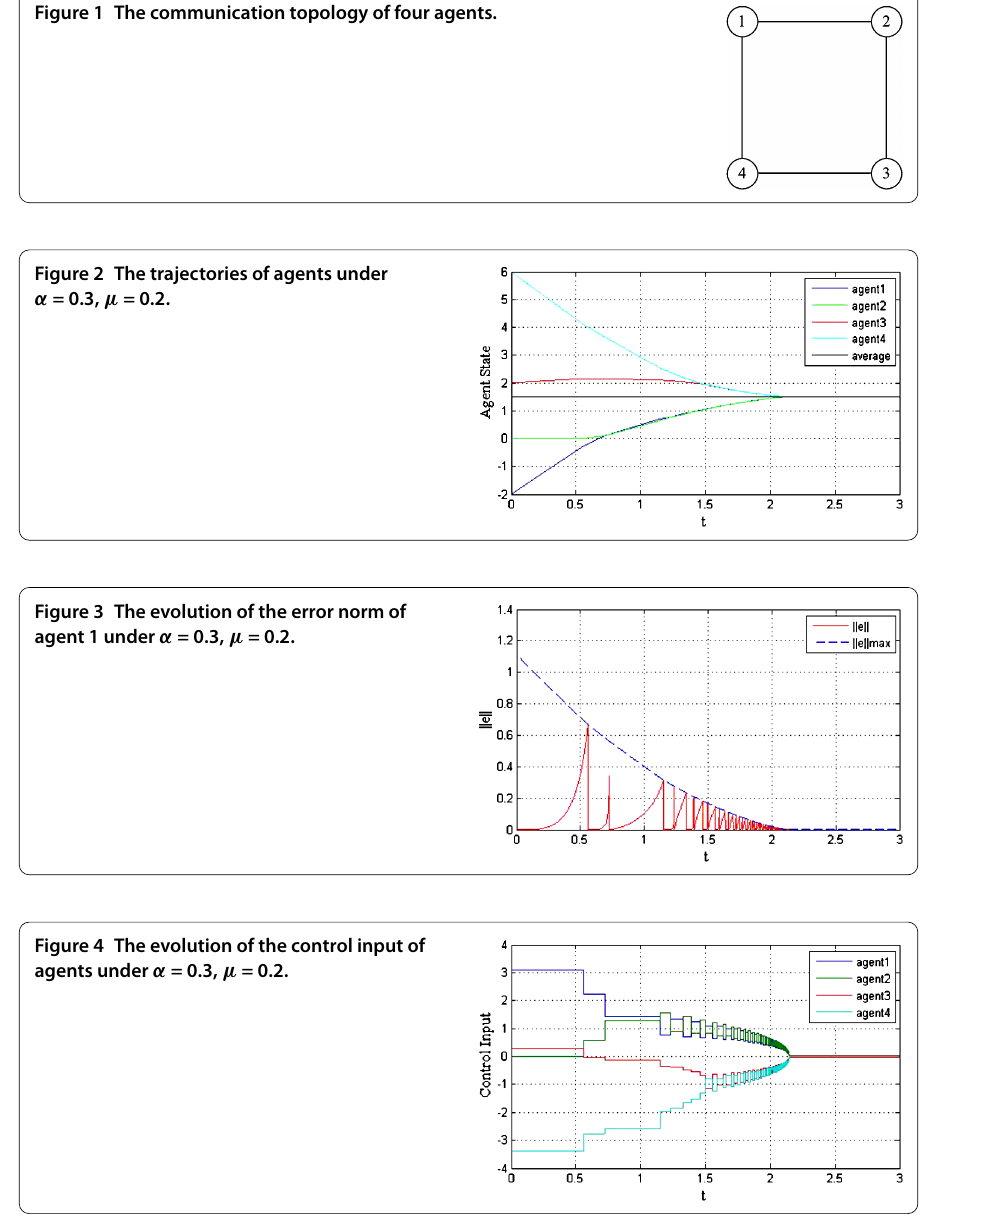
Figure 4 The evolution of the control input of agents under α = 0.3, μ =